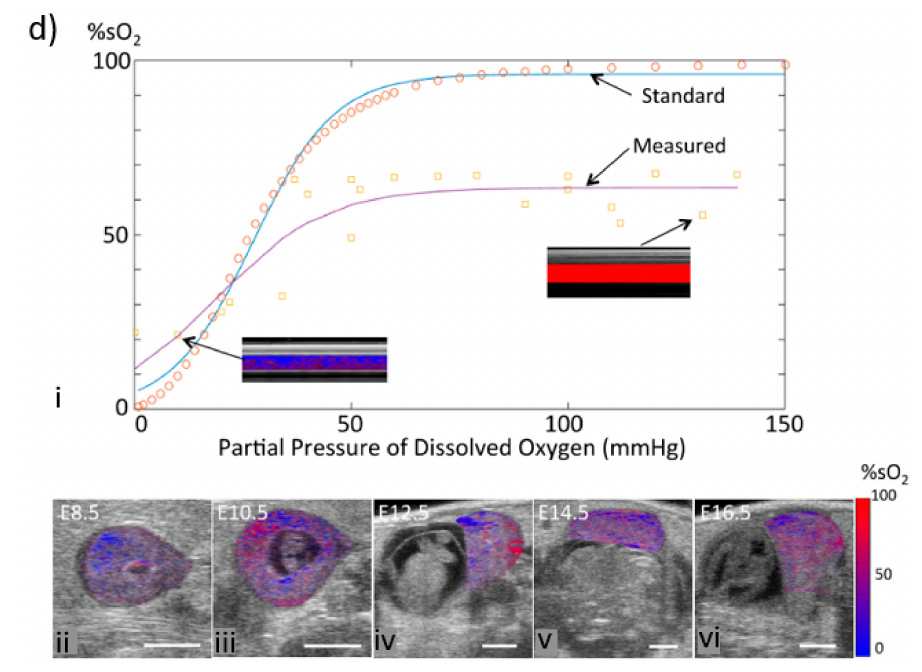
Figure 2. ( a ) PAM measurement of hemodynamic responses to a hyperthermic challenge (red bars) and the relative changes (reproduced with permission from [22]. Copyright SPIE, 2011). ( b ) Simultaneous PAM of ( i ) vascular anatomy; ( ii ) oxygen saturation of hemoglobin (sO 2 ); and ( iii ) blood flow speed in a nude mouse ear in vivo and their dynamics (reproduced with permission from [23]. Copyright The Optical Society, 2015). ( c ) Quantification of mouse brain oxygenation responses to electrical stimulations (reproduced with permission from [24]. Copyright Nature Publishing Group, 2015). ( d ) Longitudinal in vivo imaging of regional tissue sO 2 during development (reproduced with permission from